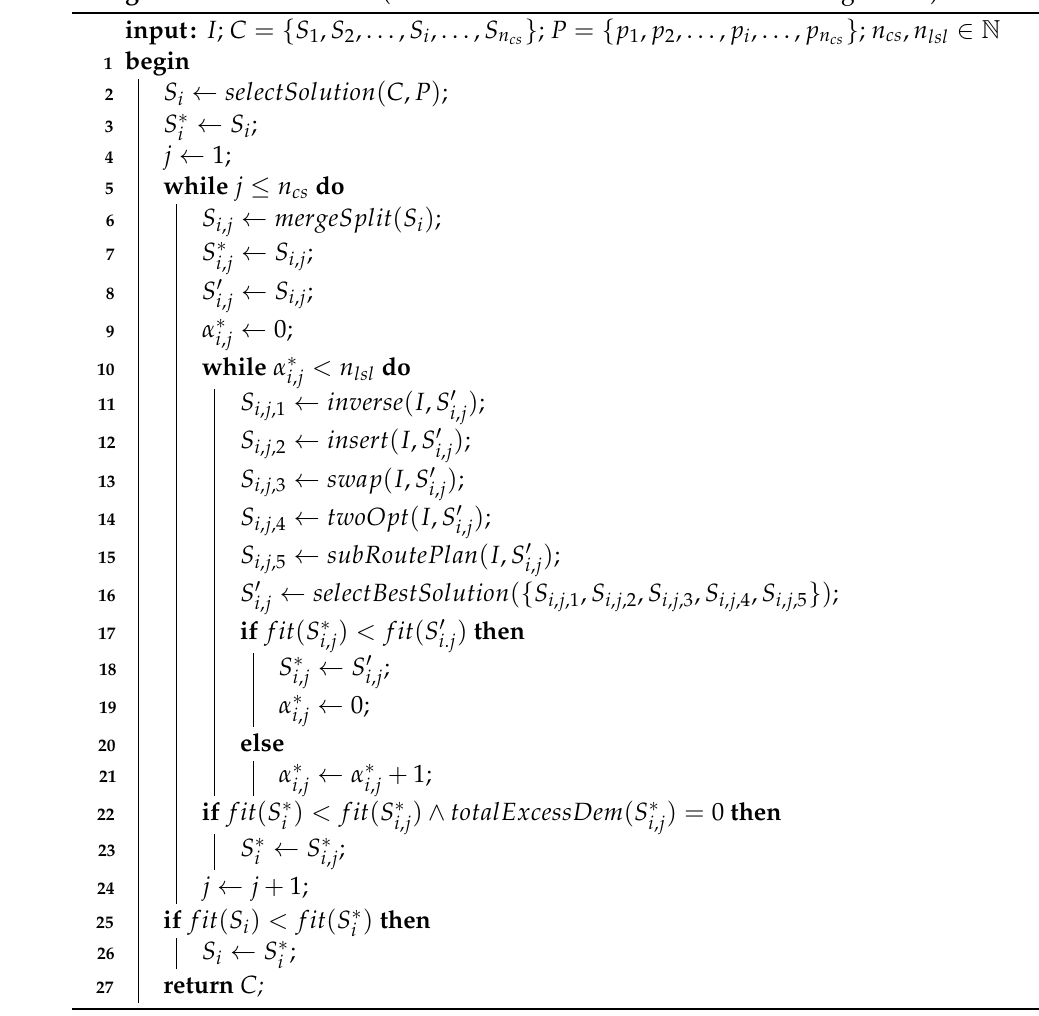
Algorithm 4: onlookerBP (Onlooker Bee Phase of the CARP-ABC